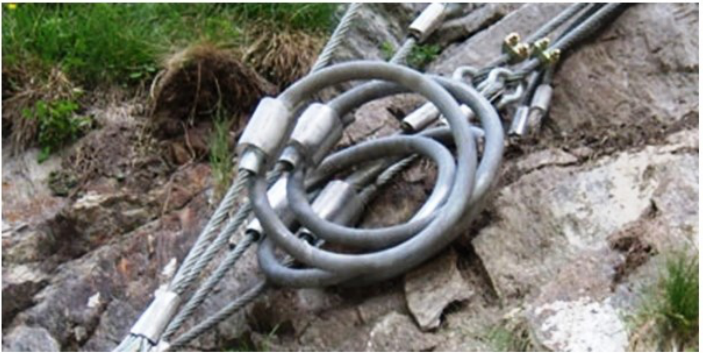
Figure 7. Detail of a loop-type breaking element (energy absorber) of the dynamic barrier.